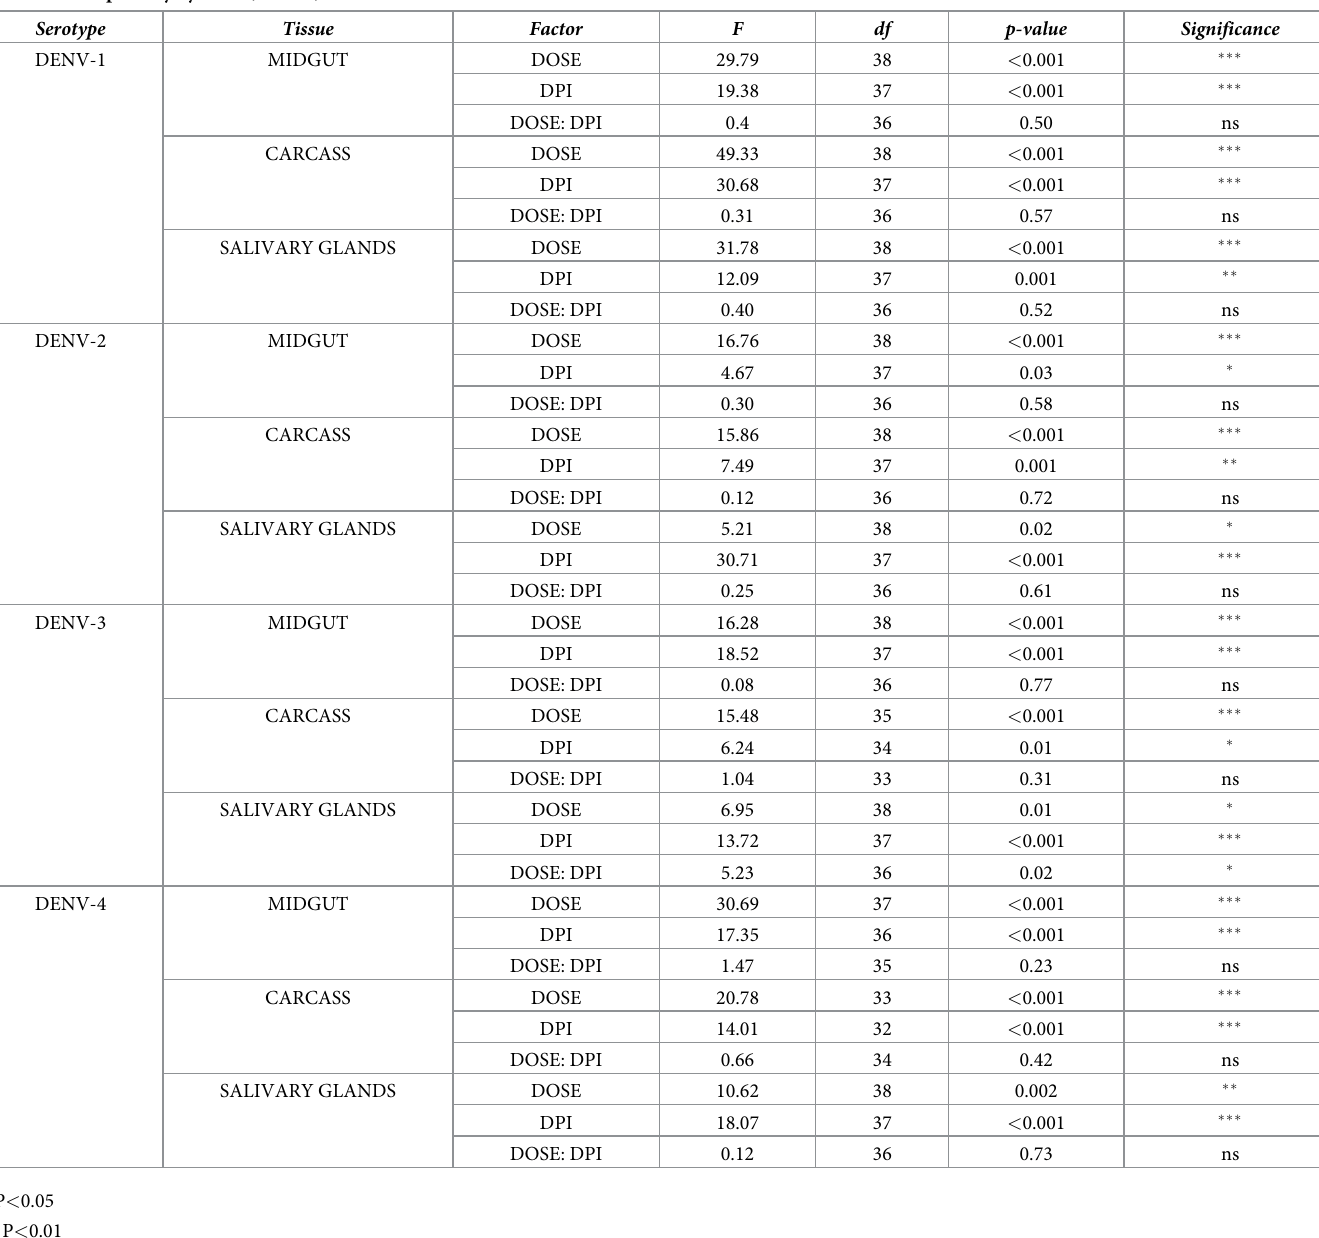
Table 1. Susceptibility by Strain, Tissue, Dose and DPI.